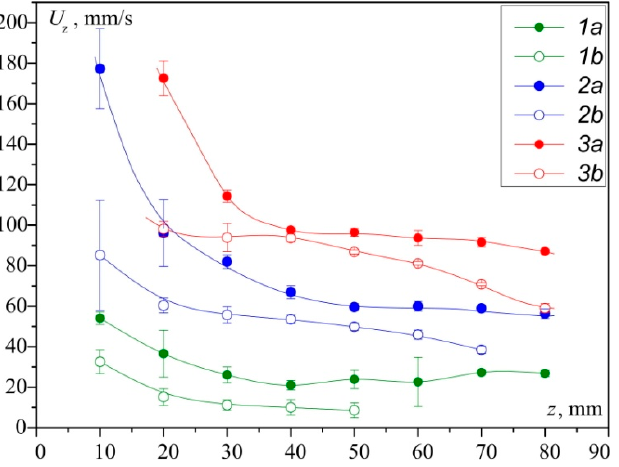
Figure 10. The dependence of the axial velocity on the depth z at a different currents. Index a — Maxwell coil is turned on, b —off . 1— 100 A; 2 —250 A; and 3 —450 A.